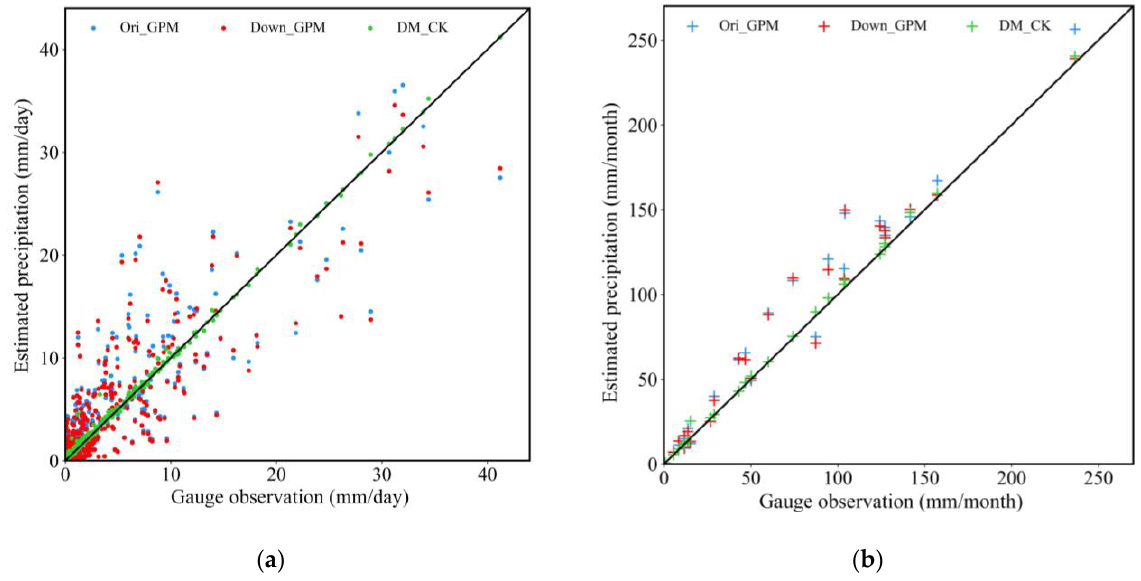
Figure 11. Scatterplots of BADP: basin average daily precipitation ( a ) and BAMP: basin average monthly precipitation ( b ) from the Ori_GPM, Down_GPM, and DM_CK against the gauge observations from March 2016 to February 2018. Table 5. Evaluation for quantitative indices of BADP and BAMP from the Ori_GPM, Down_GPM, and DM_CK over the study area from March 2016 to February